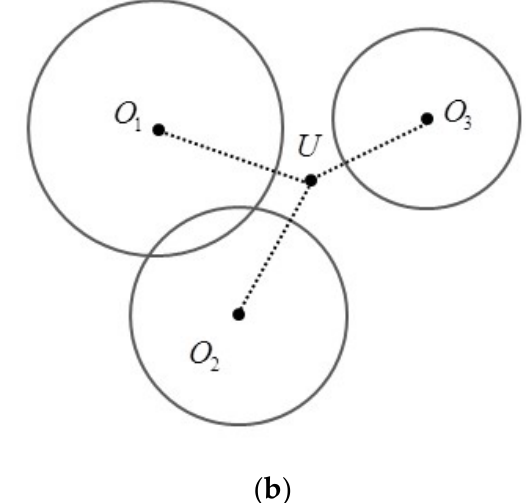
Figure 11. ( a ) Location relationships of three circles in ideal conditions; ( b ) Location relationships of three circles in real conditions.